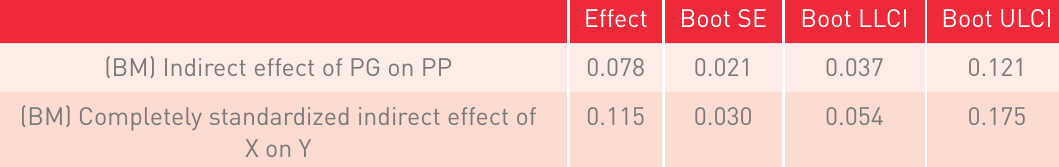
Bootstrap results